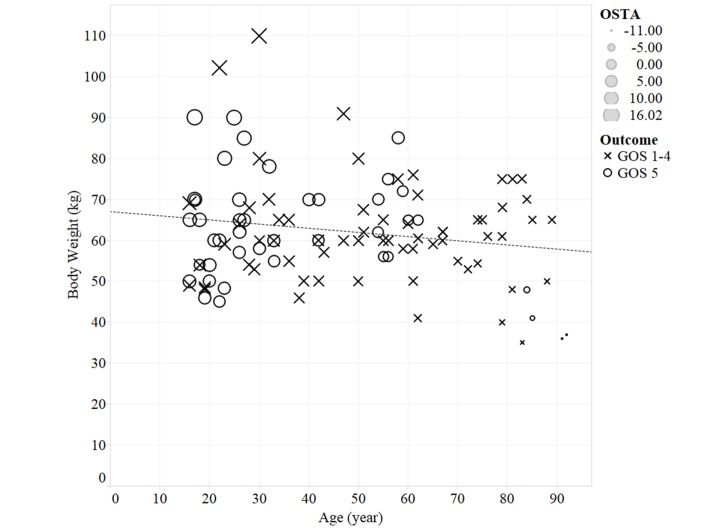
Scatter plot of Body weight and age both labelled by OSTA undex.The scatter plot displayed no significant correlation between body weight and age in our study cohort. (Pearson’s r = -0.064, p = 0.515). The size of the symbol indicates the OSTA value.